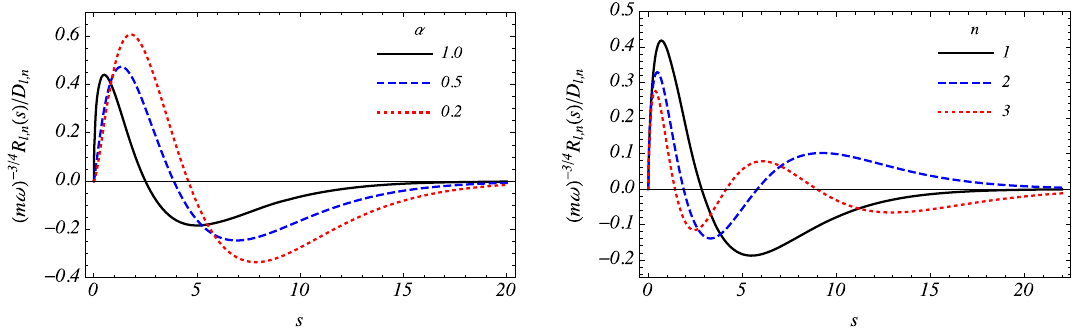
Fig. 4 Profile of the eigenfunction R l , n ( s ) as function of the coordinate s . In the left plot, we have n = 1 and different values of the parameter α . In the right plot, we have α = 0 . 8 and different energy levels. In addition, we have l = 1 and ξ = 0 in both plots